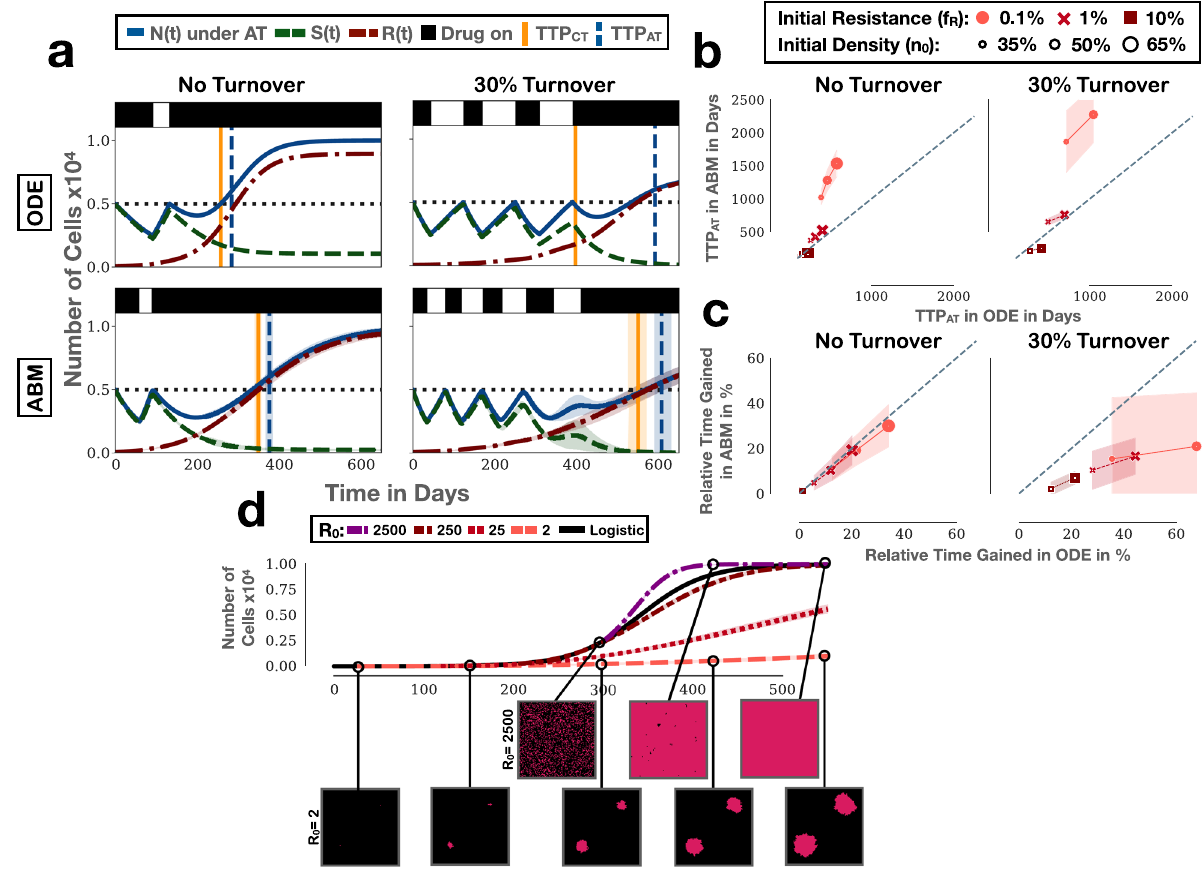
Fig. 5 Comparison of the spatial ABM with the corresponding non-spatial ODE model from 32 , which uses a Lotka – Volterra model to describe competitive growth inhibition (Equations (2) – (4)). AT: adaptive therapy, CT: continuous therapy, TTP: time to progression, TTP CT : TTP under CT, TTP AT : TTP under AT, ODE: ordinary differential equation model, ABM: agent-based model. a ODE and ABM simulations with the same parameters (( n 0 , f R , c R ) = (50%, 1%, 0%); n = 250 replicates for the ABM). b Comparison of the TTP under adaptive therapy in the ODE and ABM ( c R = 0%). The ABM predicts faster progression when initial resistant cell numbers are high, and slower progression when numbers are low ( n = 1000 replicates of the ABM). Note that in the presence of turnover, tumours initialised at n 0 = 65% can not grow above the threshold de fi ning progression and thus, no TTP can be obtained. c Comparison of the relative bene fi t of adaptive therapy ((TTP AT – TTP CT )/TTP CT ) in the two models. The ODE model tends to predict larger bene fi t than the ABM. Again, no TTP can be obtained for n 0 = 65%. d Depending on the initial cell number ( R 0 ) the resistant population will grow sub- or super-logistically (logistic growth: black solid line). Resistant cells were seeded and grown in isolation and without drug ( n = 250). To allow direct comparison with logistic growth, the ABM curves were shifted to start at the time at which the logistic model reached the corresponding starting number of cells. Throughout this fi gure lines and shading denote the mean and standard